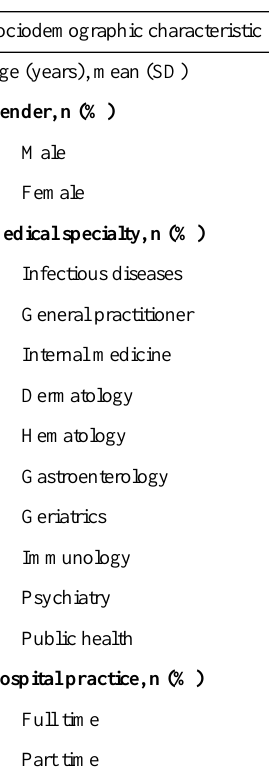
Table 3. Sociodemographic characteristics of physicians (N=219).